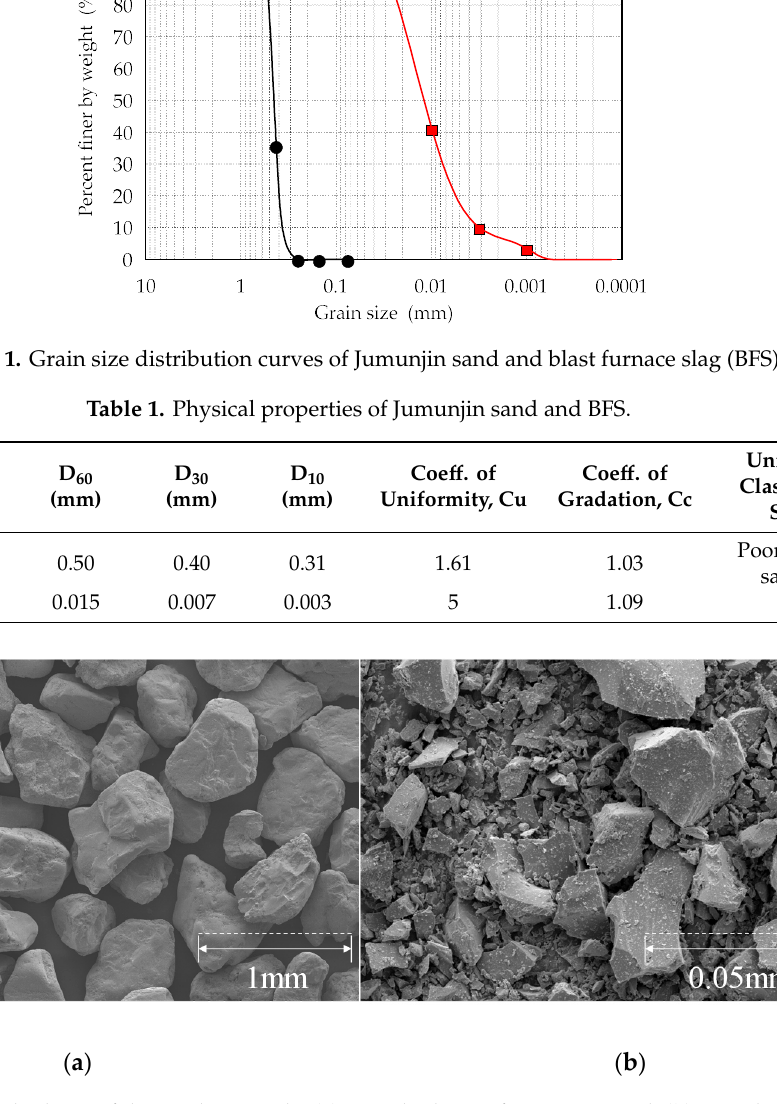
Figure 2. Particle shape of the used materials. ( a ) Particle shape of Jumunjin sand, ( b ) Particle shape of blast furnace slag. Table 3. Chemical components of BFS. Table 2. Chemical components of Jumunjin sand. Table 1. Physical properties of Jumunjin sand and BFS.